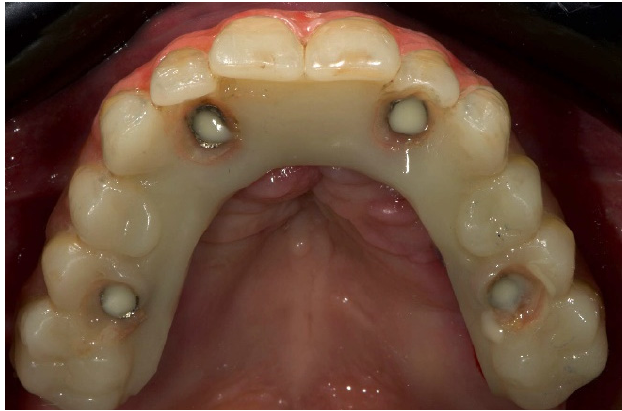
Figure 15. Temporary restoration, occlusal view.